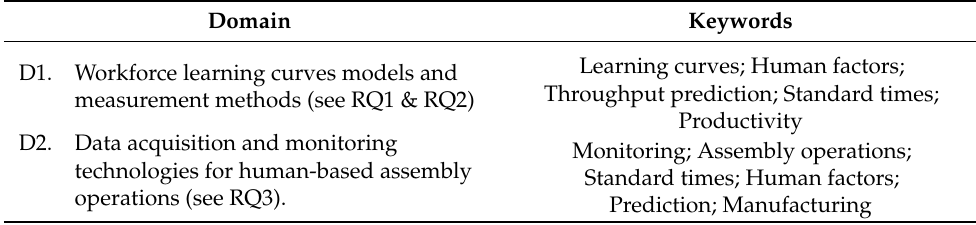
Table 2. Keywords selection.